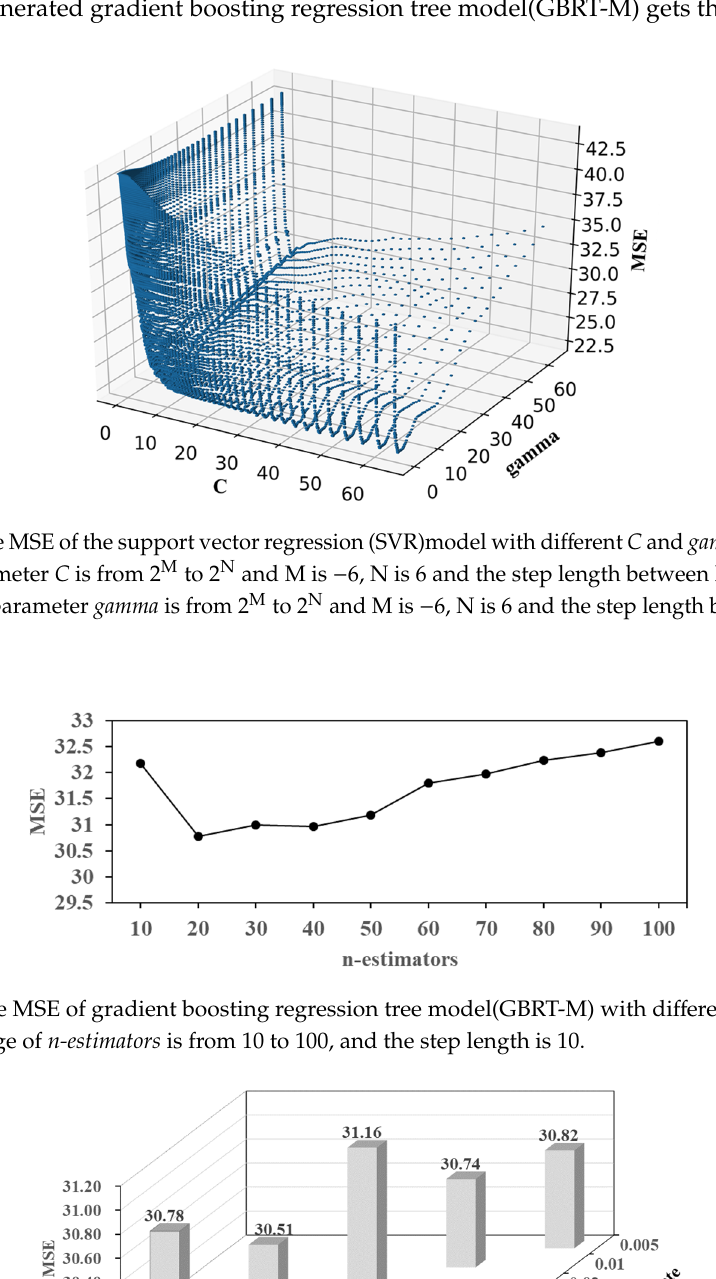
Figure 12. The MSE of the support vector regression (SVR)model with different C and gamma . Note: The range of parameter C is from 2 M to 2 N and M is −6, N is 6 and the step length between M and N is 0.1; The range of parameter gamma is from 2 M to 2 N and M is −6, N is 6 and the step length between M and N is 0.1;.